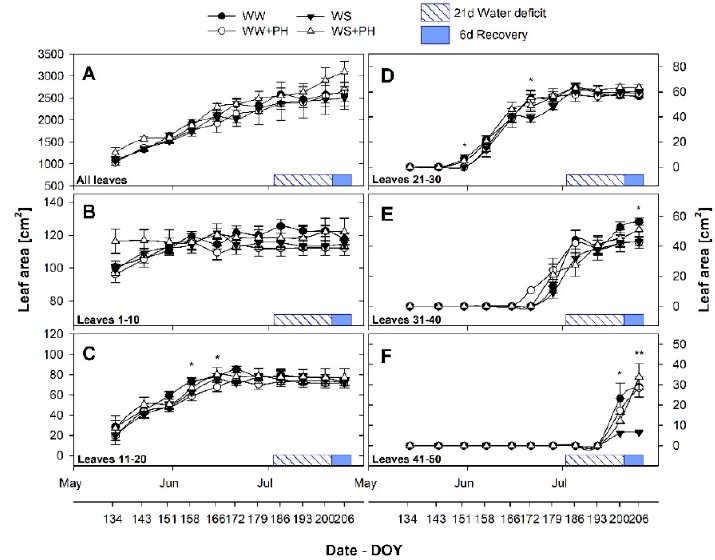
Figure 3. ( A ) Effects of water stress (WS) compared with well-watered conditions (WW) and PH provision, on shoot length growth dynamics throughout the season. Elongation dynamics of entire shoots (cumulative for all leaves and nodes) ( A ) and of mean internode classes ( B – F ): 1–10 (class I) ( B ), 11–20 (class II) ( C ), 21–30 (class III) ( D ), 31–40 (class IV) ( E ), and 41–50 (class V) ( F ). Values are means ± SE ( n = 6), asterisks indicate significant differences among treatments according to repeated measurements ANOVA ( p < 0.0083, p < 0.002 and p < 0.0008 after sequential Bonferroni adjustment for α = 0.05 (*) and α = 0.01 (**), respectively).